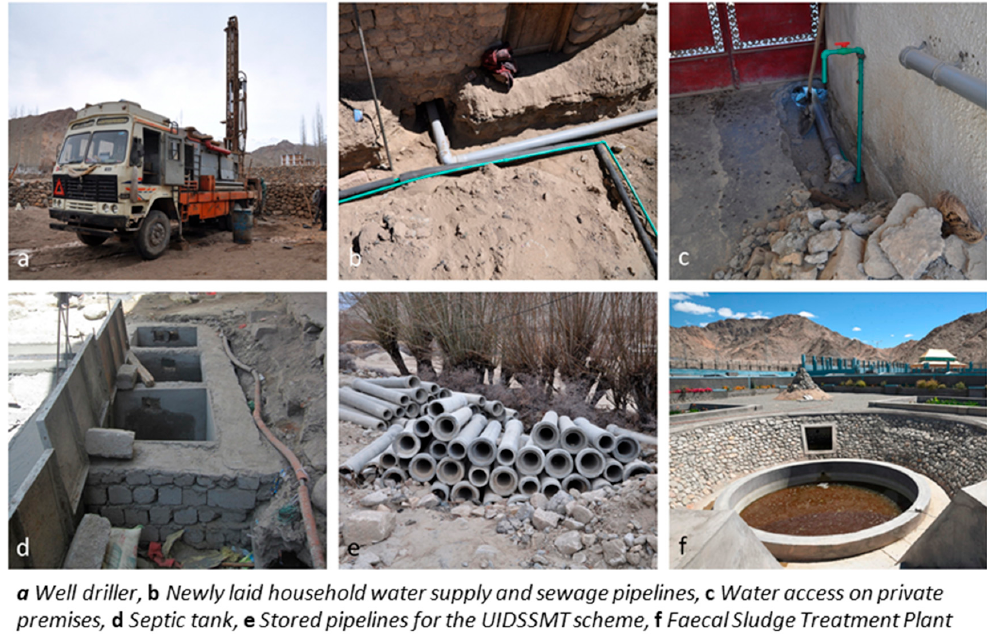
Figure 4. Water infrastructures commonly used for water supply (photos taken by Judith Müller, 2015–2018).